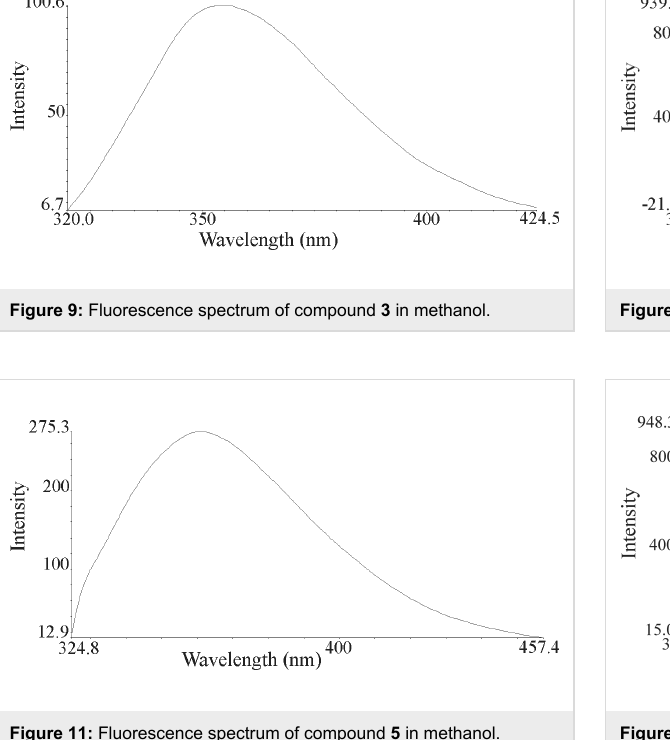
Figure 11: Fluorescence spectrum of compound 5 in methanol.